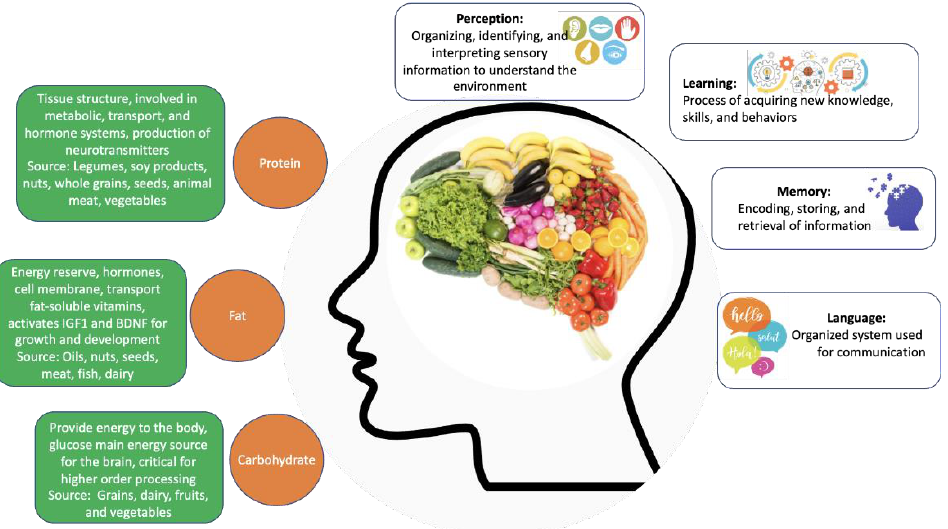
Figure 1. The contribution of individual macronutrients to brain health and cognitive function. Source: Author’s own work.